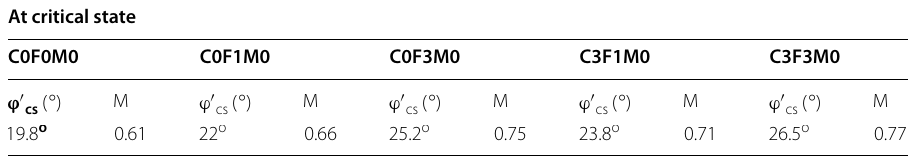
Table. 7 Slope of the critical state line, M for unreinforced, fibre reinforced, and fibre reinforced cemented Toyoura sand from CID extension tests